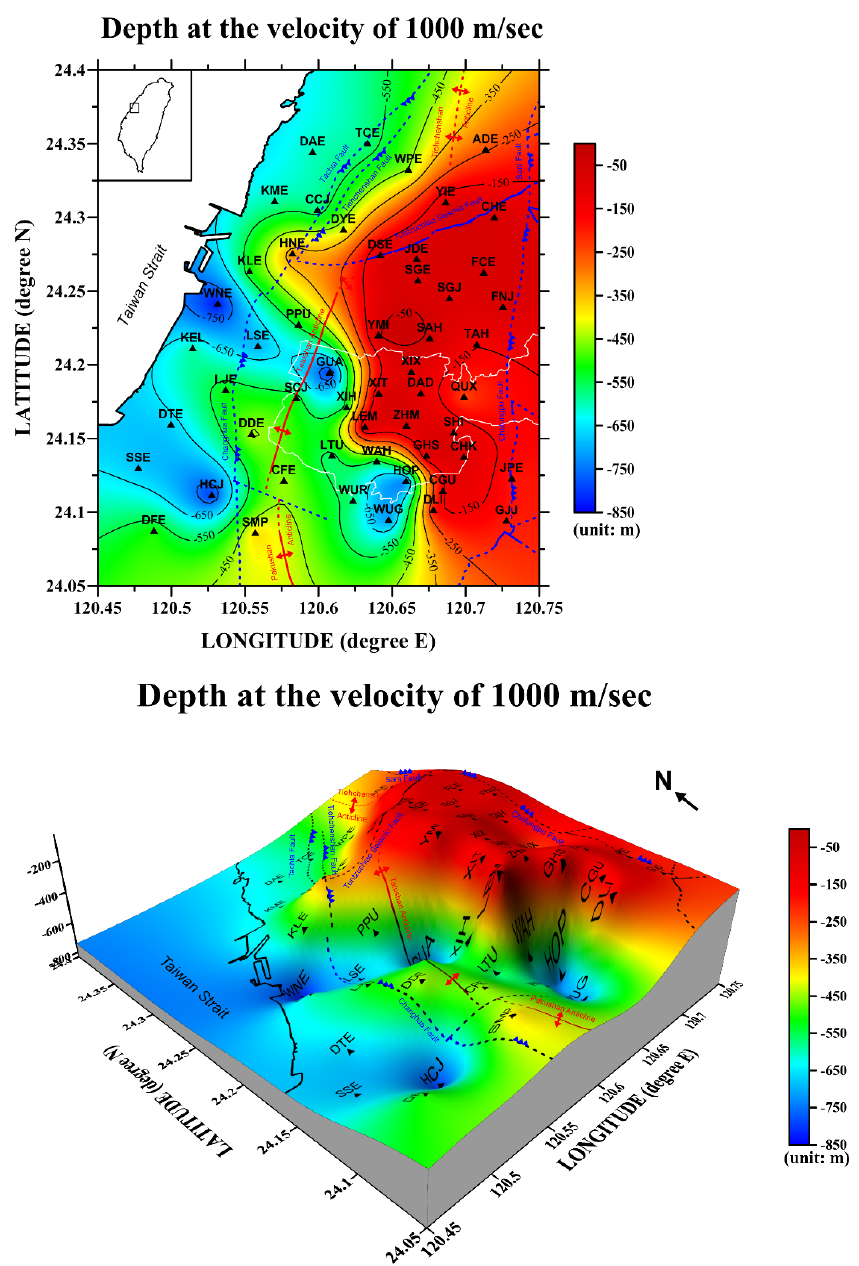
Figure 12. Contour map (upper panel) and 3D structure (lower panel) of the depth variations at the velocity of 1000 m/s in the Taichung area.